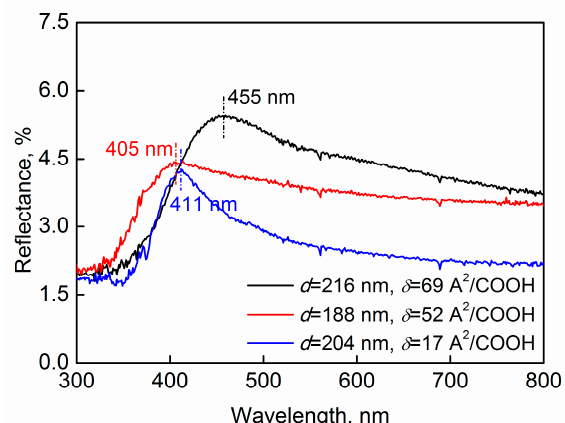
Figure 6. Reflectance spectra of the colloidal crystal films prepared from COOH–PS particle/water latex with different particle surface charges. The measurement incident angle was 15°.